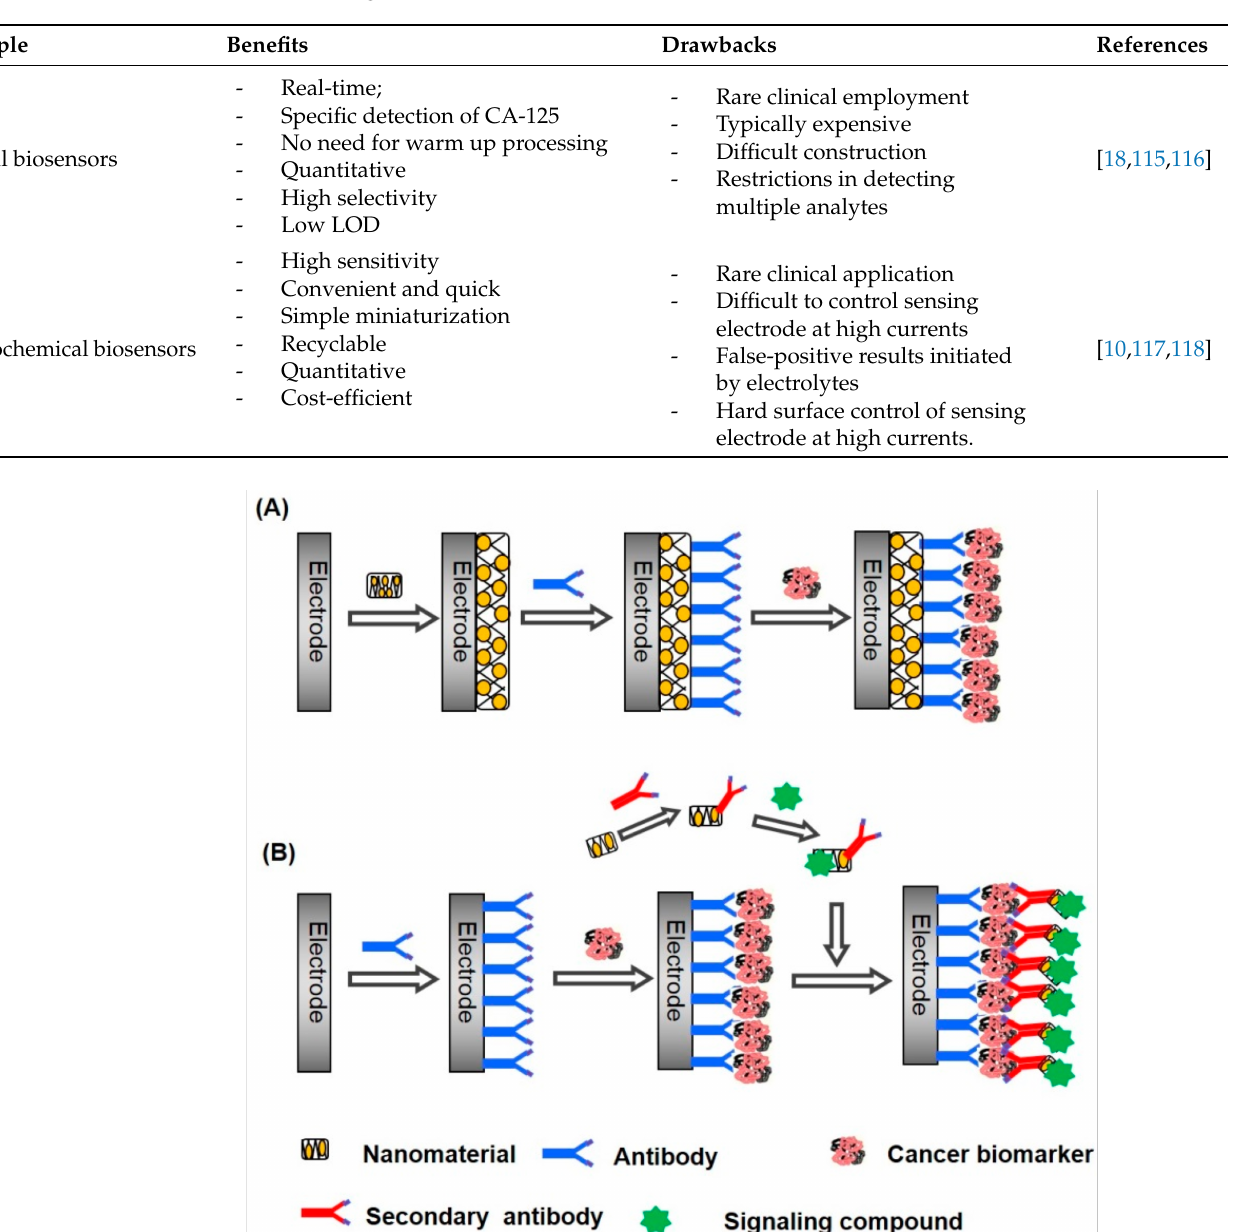
Table 4. Comparison of benefits and drawbacks of optical and electrochemical sensors for detecting CA-125 antigen.